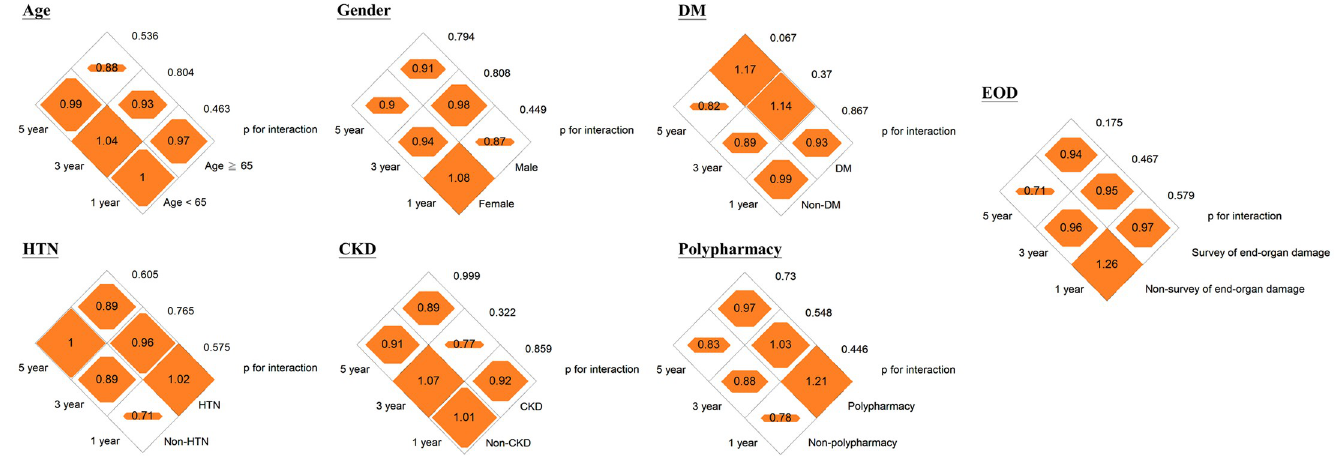
Fig 3. Diamond graphs summarize the adjusted hazard ratios (HRs) of 7-day, 30-day, and 60-day cardiovascular mortality by clinical characteristics of the study population. DM, diabetes; HTN, hypertension; CKD, chronic kidney disease; EOD, end-organ damage. Numbers in the orange diamonds stand for the adjusted HRs, where the bold numbers represent the 95% confidence interval not overlapping with null value 1.0. Detailed information is provided in the S3B Table.